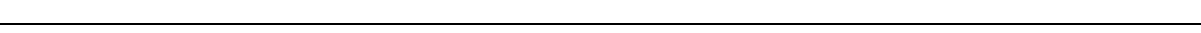
Fig. 3 FBXO32-mediated K63-linked ubiquitination of CtBP1 is required for its stability and nuclear retention. a Analysis of FBXO32 interaction partners by af fi nity puri fi cation-mass spectrometry. Volcano plot of three replicate showing selected signi fi cantly enriched proteins in FBXO32 immunoprecipitated samples. HMLE cells were transfected with Flag-tagged FBXO32 or an empty vector and were induced with TGF- β for 4 days. FBXO32 and interaction partners were immunoprecipitated using Flag af fi nity resin, followed by their identi fi cation via LC-MS/MS. b Western blot of immunoprecipitated samples to validate FBXO32 and CtBP1 interactions. HEK293T cells were co-transfected with Myc-CtBP1 and Flag-HA-FBXO32 and anti-CtBP1 IP was performed. Immunoblot was performed to detect FBXO32 and CtBP1. c Western blot of immunoprecipitated samples to validate FBXO32 and CtBP1 endogenous interactions in MDA-MB-231 cell. FBXO32 IP was performed and Immunoblot was performed to detect CtBP1 and FBXO32. d HEK293 were transfected with various tagged construct as mentioned in the fi gure. Four hours before immunoprecipitation MG132 was added for all conditions. Western blot for CtBP1 ( α -Myc) immunoprecipitated samples was performed to detect ubiquitin ( α -HA) and CTBP1. β -Actin, FBXO32 and Ubiquitin were detected in Input samples as controls. e Western blot to access protein stability, showing CtBP1 and FBXO32 protein levels at various time points after cyclohexamide treatment in HMEC cells transfected with control siRNA or siRNA against FBXO32. β -Actin acted as a loading control. f Immuno fl uorescence image showing CtBP1 localization in control and FBXO32-depleted HEK293T cells. Magni fi ed images of the nuclei are provided in the lower left corner of